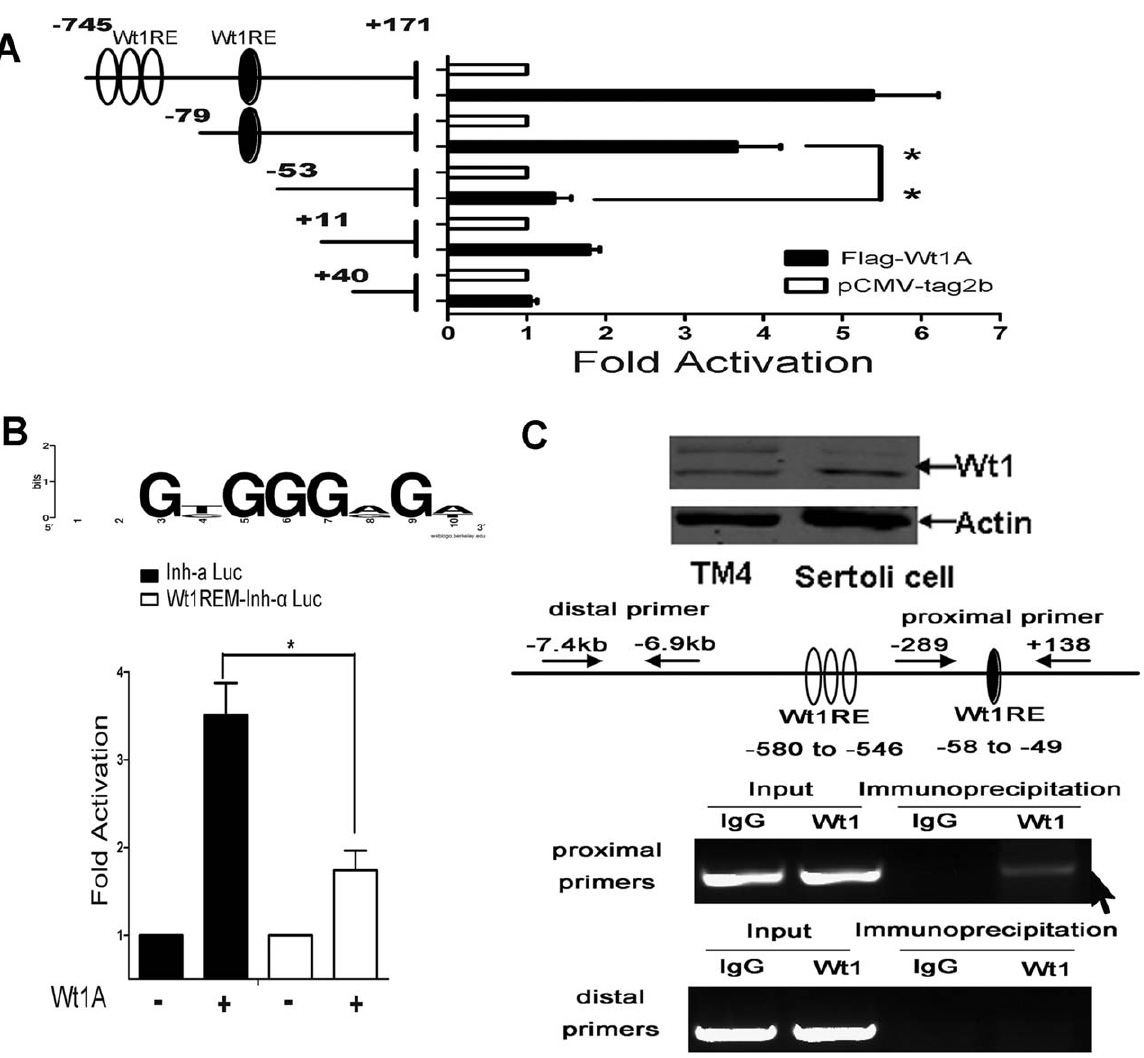
Figure 3. Identification of the DNA sequence within the mouse inhibin- a promoter required for Wt1A-dependent transcriptional activation. A, TM4 cells were transiently transfected with luciferase reporter constructs bearing different lengths of the mouse Inhibin alpha promoter sequence, and Renilla luciferase reporter plasmids together with an empty plasmid (pCMV-tag2b) or Wt1A expression vector. The filled and open ovals indicated putative Wt1 response elements (Wt1RE). B, The Wt1-dependent transactivational activity of inhibin- a promoter was significantly decreased after deletion of the ten base pairs (5 9 - GGC GGG AGT G -3 9 ) sequence including part of the Wt1 consensus binding motif. C, Western blot showed the endogenous Wt1 protein expression in TM4 cells and primary Sertoli cells. TM4 cells were transiently transfected with the empty plasmid or with the expression plasmid for Flag-Wt1A. 48 h after transfection, cells were cross-linked with formaldehyde and cross-linked chromatin was sonicated followed by immunoprecipitation with anti-Flag antibody. Genomic DNA was purified from the immunoprecipitates and subjected to PCR using the primers as indicated in schematic drawing of Inhibin- a promoter and distal primers as negative control. A specific PCR product (black arrow) was amplified in Flag-Wt1A transfected cells with proximal primers, not with the distal primers. Normal mouse IgG served as a negative control.